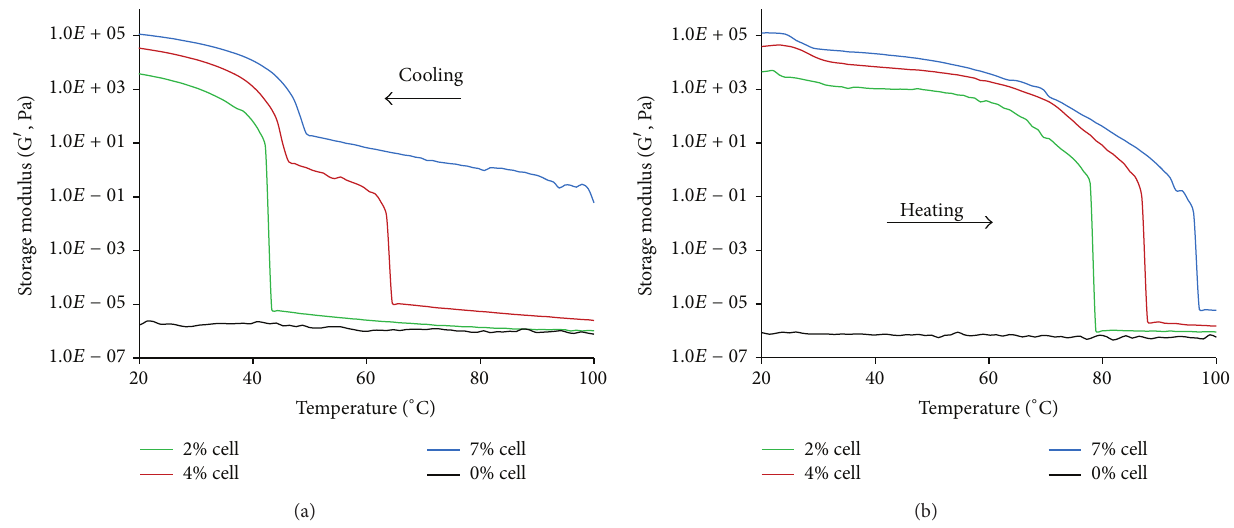
Figure 1: Effect of cellulose concentration of storage modulus with temperature for AMIMCl solutions on cooling (a) and heating (b). Pure AMIMCl (black), 2% cellulose (green), 4% cellulose (red), and 7% cellulose (blue)